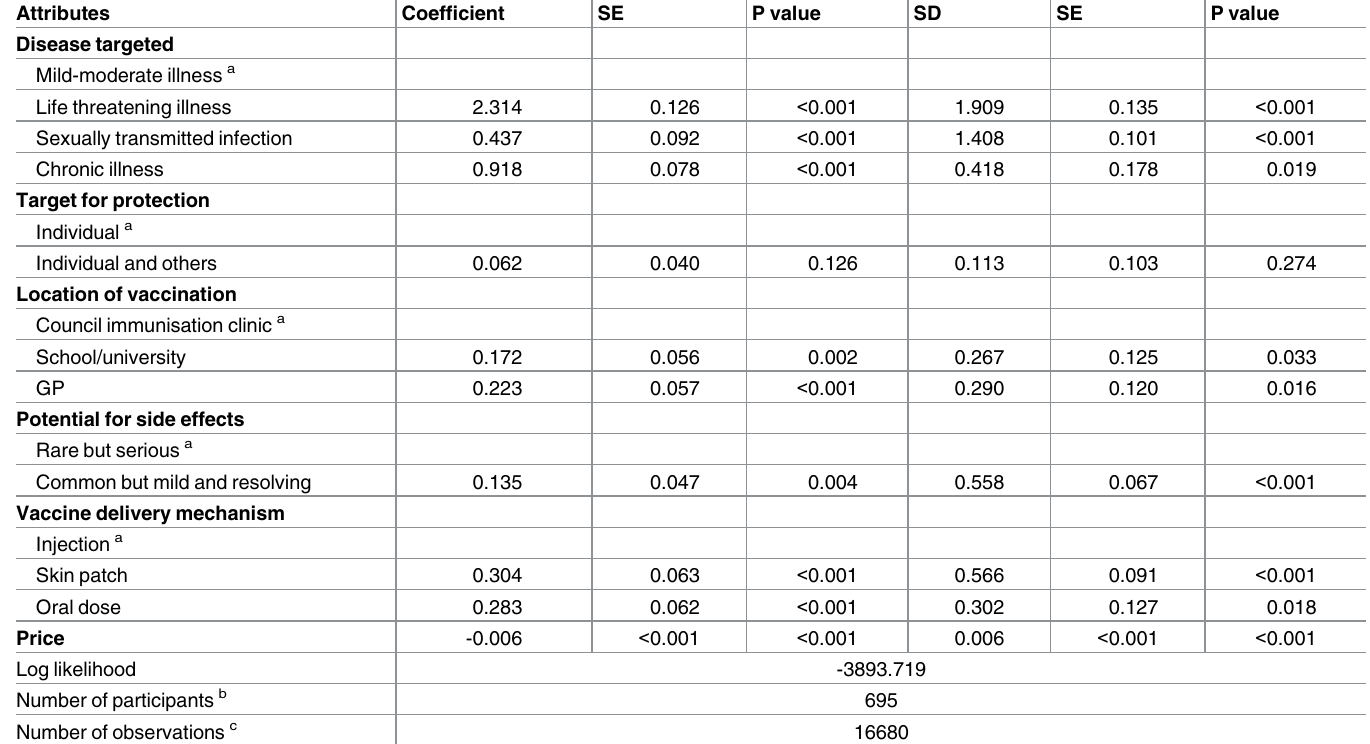
Table 3. Mixed logit estimates on vaccination